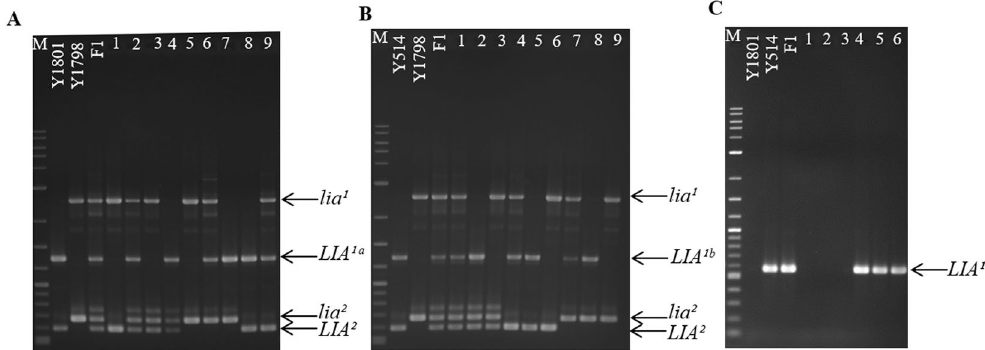
Figure 6. Identification of different C18:2 genotypes based on the SalFAD2 . LIA 1 and SalFAD 2. LIA 2 allele-specific markers in the F 2 populations of the three crosses: ( A ) Y1798 (low) × Y1801 (high); B. Y1798 (low) × Y514 (medium) and C. Y1801 (high) × Y514 (medium). A. Y1801: high C18:2